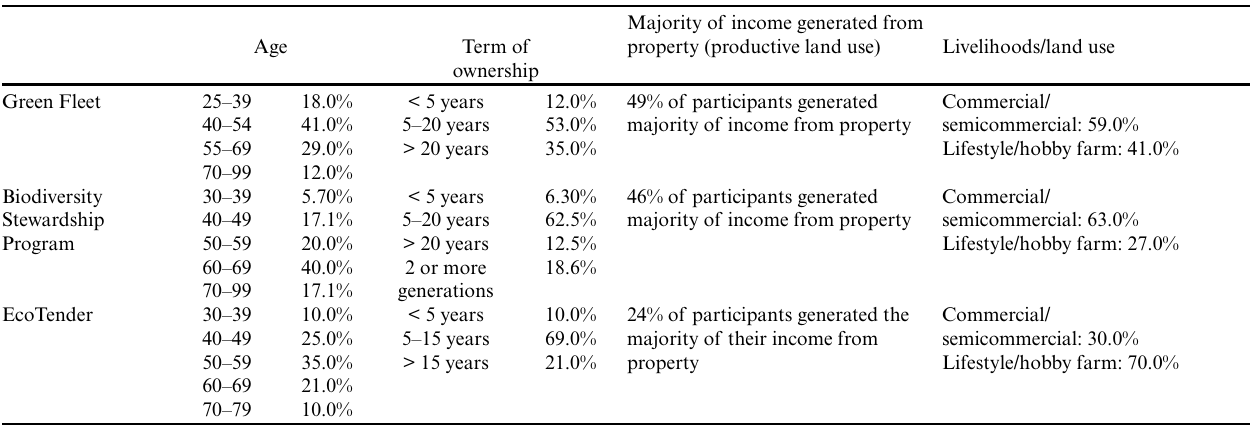
Table 3 . Socio-demographics of program